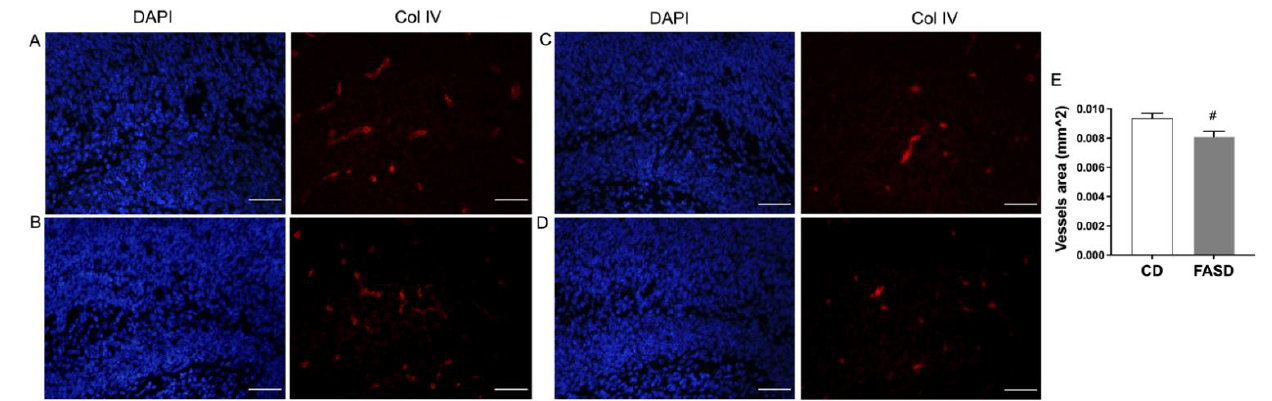
Figure 8. Collagen IV staining in the hippocampus of male embryos. ( A , B ) Representative images of two CD male embryos. ( C , D ) Representative images of two FASD male embryos. Left panels: DAPI staining, blue; right panels: collagen IV staining, red. ( E ) Vessel area was significantly decreased in the hippocampus of FASD males compared with CD males. Values are means ± SEM of 5 mice per group, with 3 sections per mouse. Nested ANOVA p -value is indicated as # p < 0.05. Scale bar = 100 µm.